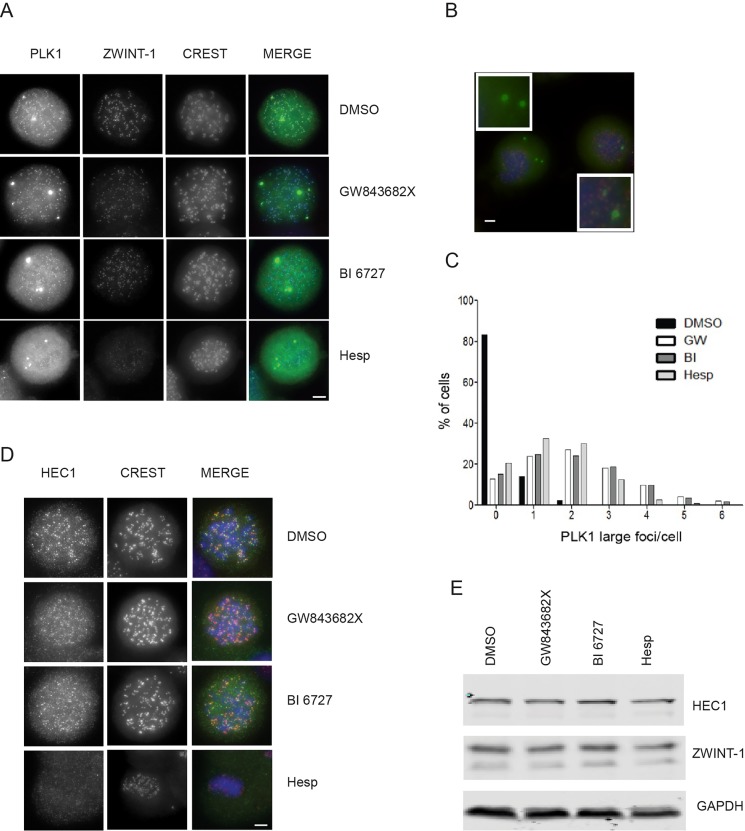
PLK1 inhibitors and an Aurora B inhibitor affect PLK1 localisation and the localisation of HEC1 and ZWINT-1 at kinetochores. Nocodazole-arrested cells were treated with either 1 μM GW843682X, 100 nM BI 6727, 500 nM Hesperadin or DMSO for 3 h in the presence of MG132 and nocodazole. Cells were stained with (A) anti-PLK1 (green), anti-ZWINT-1 (red) and CREST (blue) antibodies. Scale bar: 5 μm. (B) Representative image of Hesperadin-treated cells co-stained with anti-PLK1 (green) anti-CREST (red) antibodies and DAPI (blue). Scale bar: 5 μm. (C) Distribution of mitotic cells with large PLK1 foci after treatment with GW843682X, BI 6727, Hesperadin or DMSO as in A. At least 625 mitotic cells were counted for each treatment per repeat. (D) Cells were treated as in A and stained with anti-HEC1 (green), CREST (red) and DAPI (blue). Scale bar: 5 μm. (E) Cells were treated with nocodazole as above followed by shake-off and re-plated in the presence of nocodazole and 1 μM GW843682X, 100 nM BI 6727, 500 nM Hesperadin or DMSO for 3 h and in the presence of MG132. Proteins were analysed by western blot with the indicated antibodies.